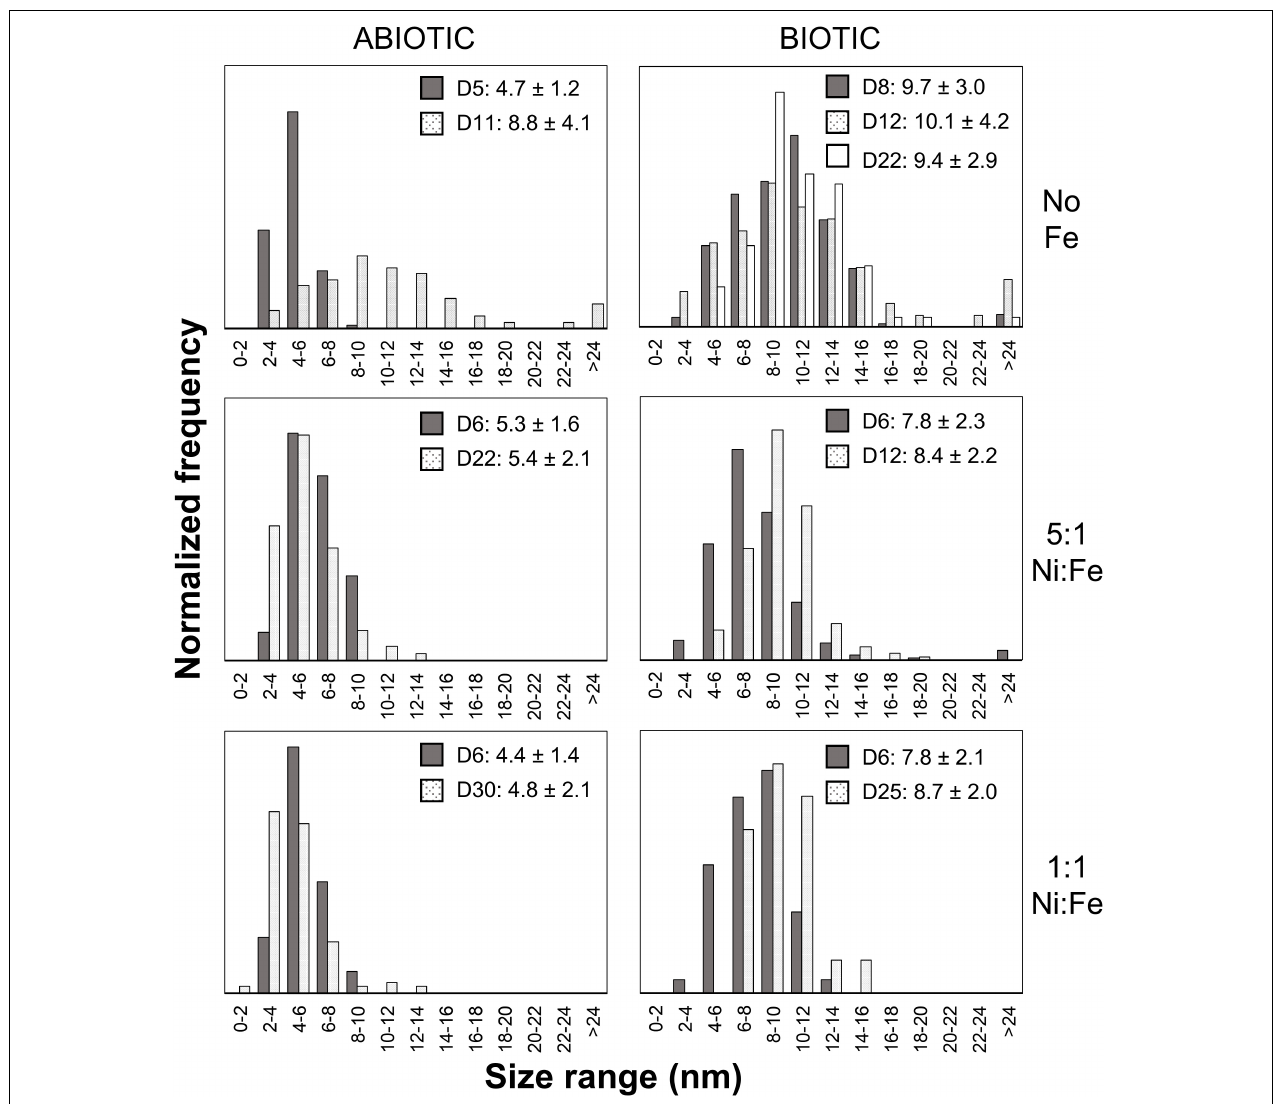
FIGURE 3 | Particle size distributions of Ni-rich nanoparticles. Over 50 particles were analyzed per sample. The legends denote the coloring for samples from different sampling day (D#) along with the average size and standard deviation in